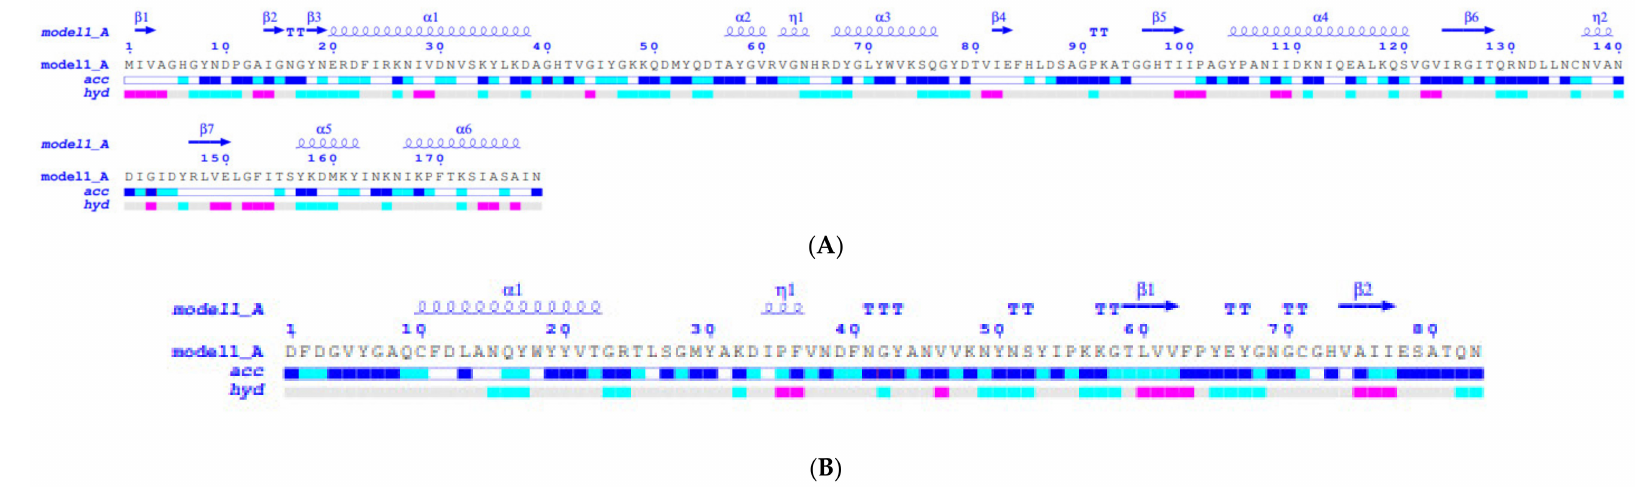
Figure 6. ENDscript analysis [33]. Flat figure showing the sequence of the MurNac-LAA ( A ) and CHAP ( B ) models, predicted by the I-TASSER approach, with secondary structure elements presented on top (helices with squiggles, β -strands with arrows and turns with TT letters). Solvent accessibility is rendered by a first bar below the sequence (blue is accessible, cyan is intermediate, white is buried) and hydropathy by a second bar below (pink is hydrophobic, white is neutral, cyan is